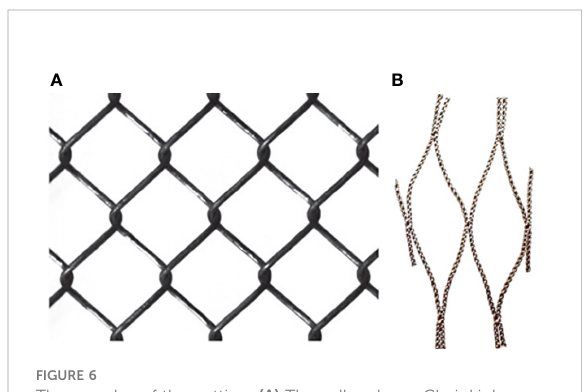
FIGURE 6 The samples of the netting. (A) The yellow brass ChainLink diamond netting, reproduced from (Tsukrov et al., 2011). (B) The four-strand braided diamond netting, reproduced from (Zhou et al.,